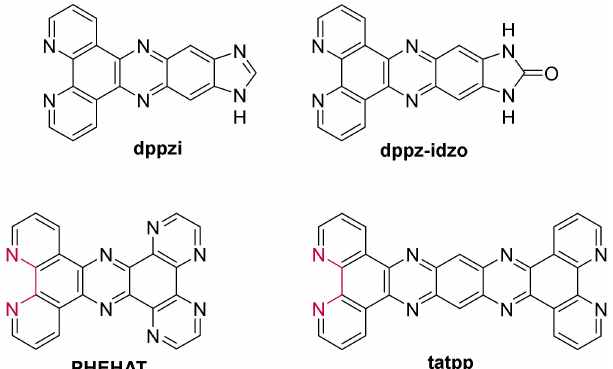
Figure 18. Structure of the π -extended symmetrical ligands form ruthenium(II) complexes studied in presence of